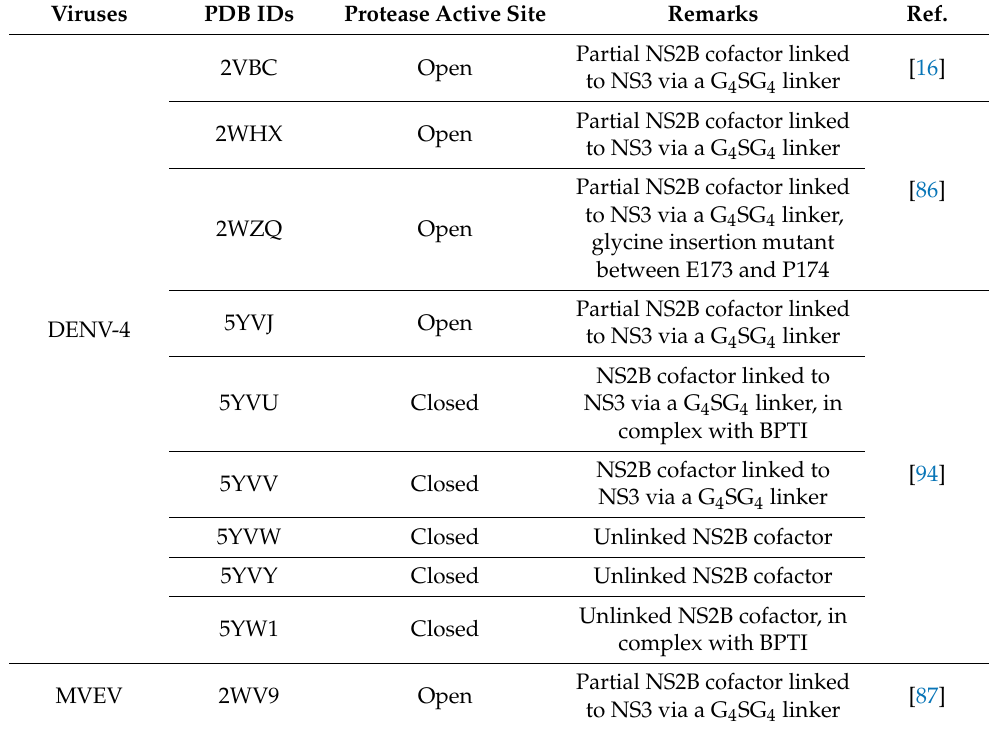
Table 2. A summary of the full-length protein structures of the NS3 proteins published in the Protein Data